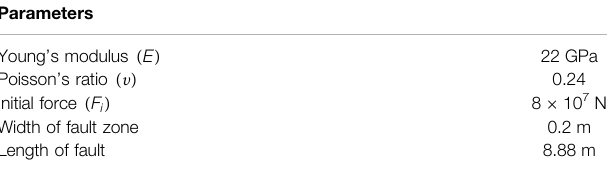
TABLE 1 | Parameters used in this model (after Nabavi et al., 2017). Parameters